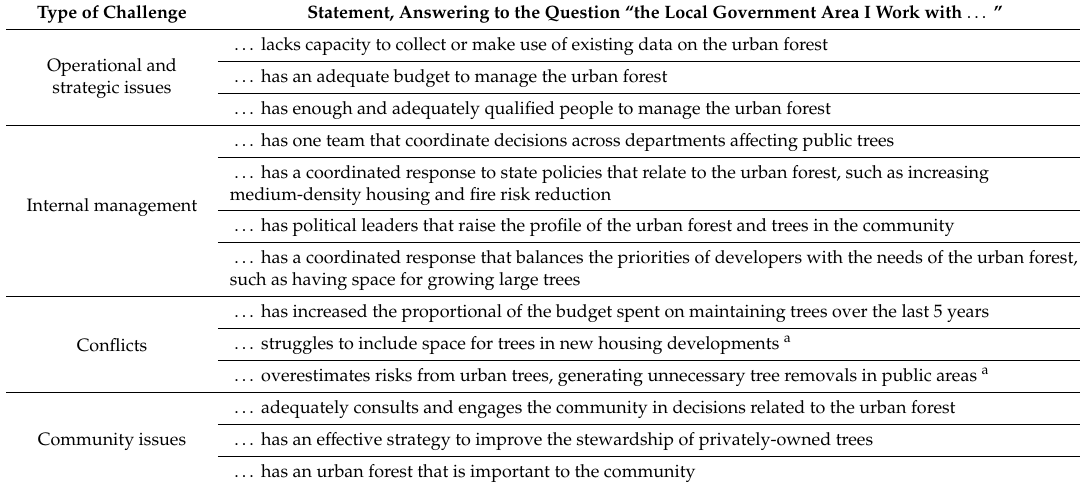
Table A2. The final list of 16 statements used for this